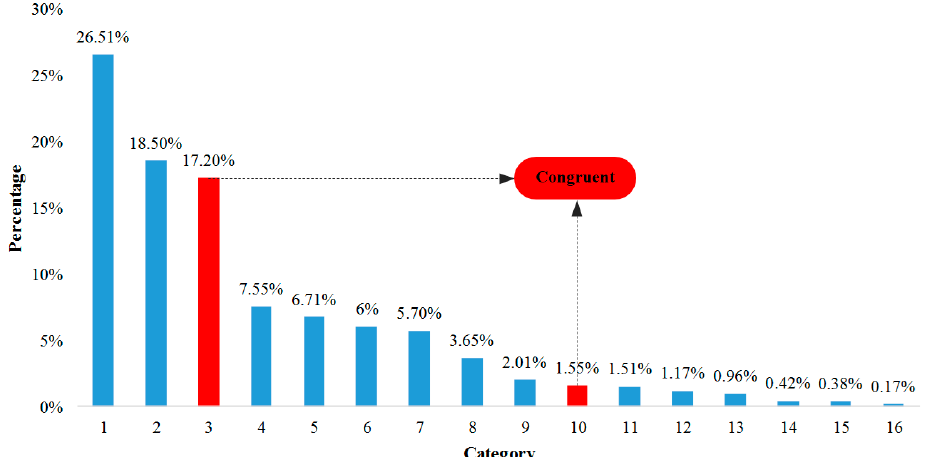
Figure 2. Public occupational safety and health psychological distance four-dimension gap analysis.